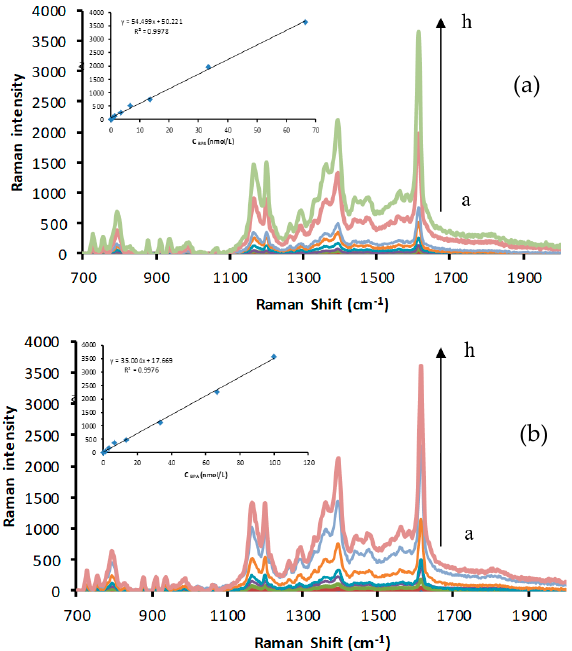
Figure 4. SERS spectra of bisphenol A (BPA) − Apt − CD − AgNO 3 − TSC: ( a ) a to h: solutions of 3.33 nmol/L Apt + 166.67 μ g/L CD − FN3 + BPA (0, 0.33, 0.67, 1.33, 3.33, 6.67, 13.33, 33.33, and 66.67